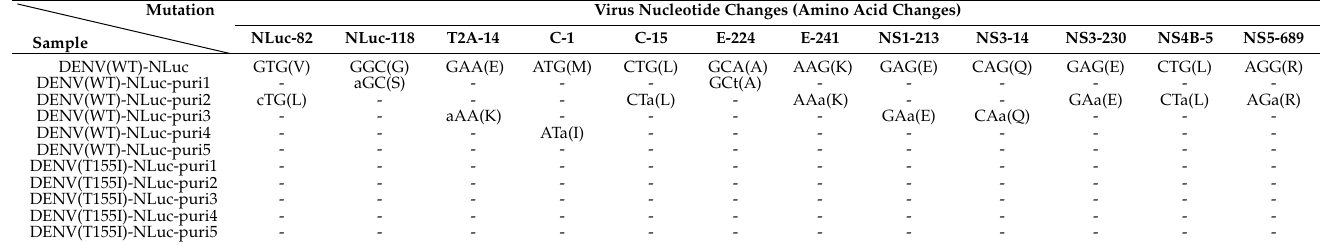
Table 1. Sequencing of plaque-purified strains of DENV with the NanoLuc reporter gene.